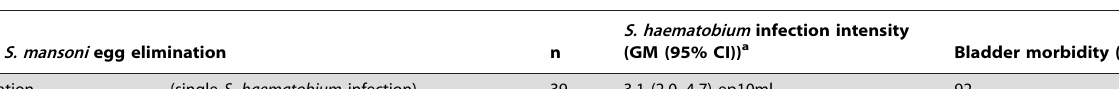
Route of S.mansoni egg